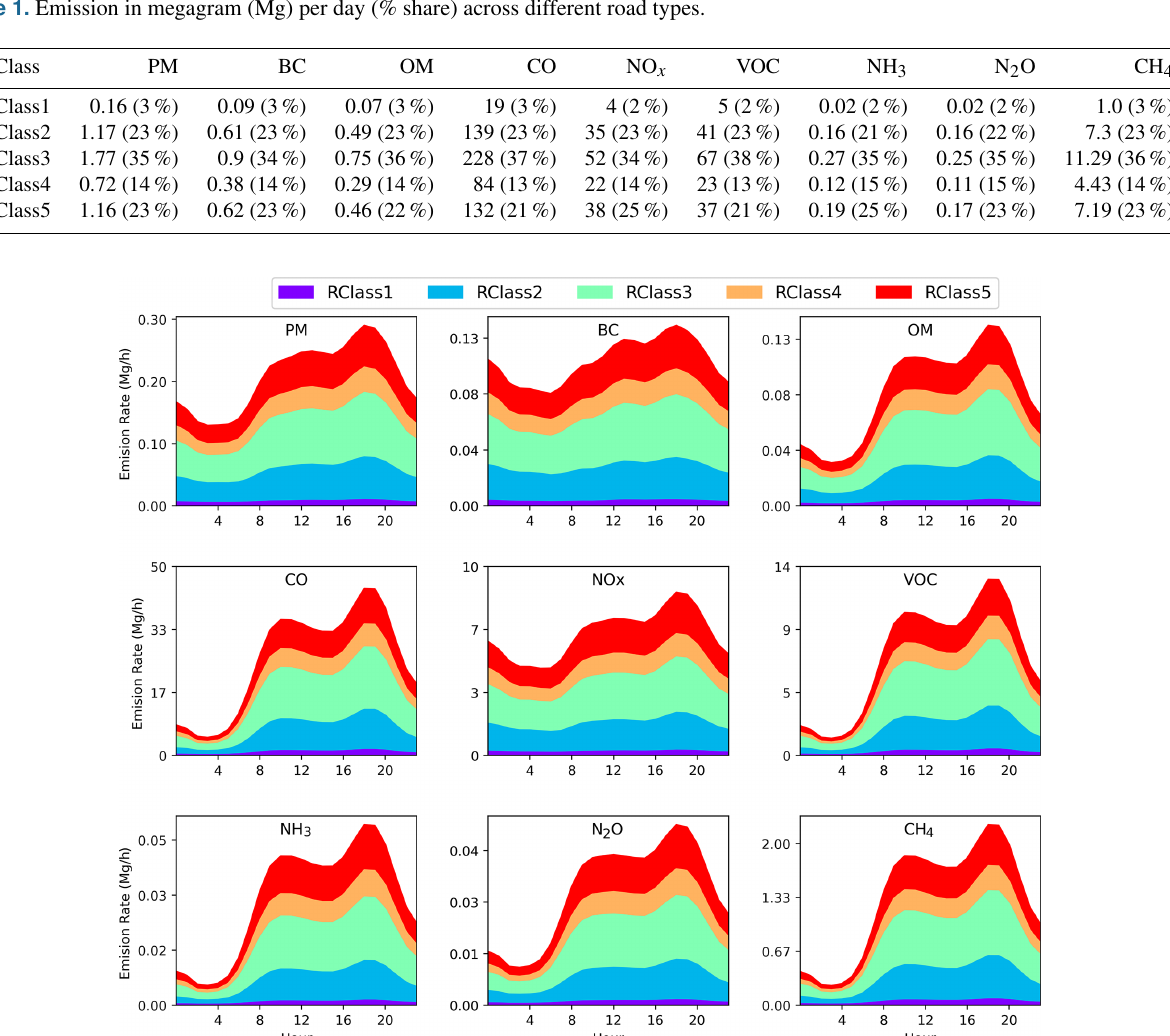
Figure 4. Variation of hourly emission (in Mgh − 1 ) of the nine pollutants averaged across Delhi according to the five road classes (RClass1 to RClass5). Different colours indicate the hourly contribution of each RClass to the total